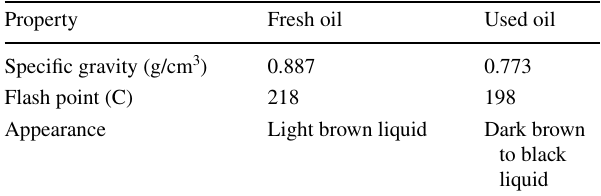
Table 1 General properties of fresh and waste oil Property